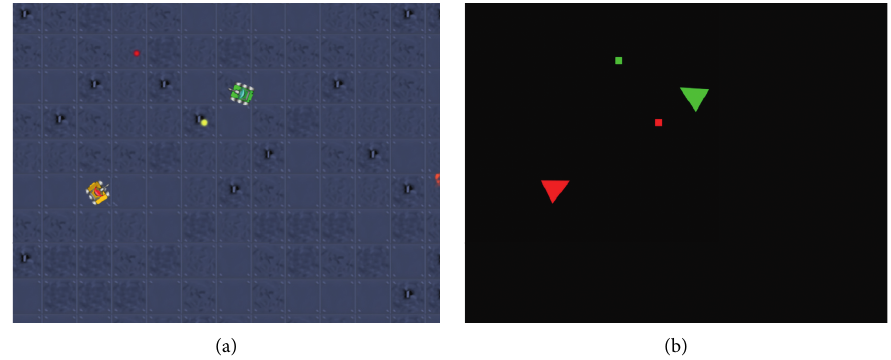
Figure 4: A screenshot of the RoboCode arena (a). Input to the deep learning model